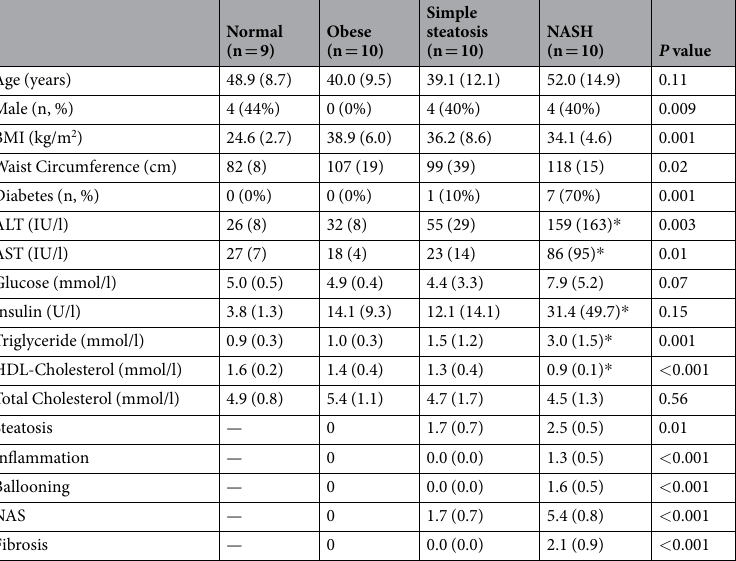
Table 1. Clinical and biochemical characteristics of control, simple steatosis and NASH patients. Footnote: Continuous data presented as mean (standard deviation). Comparison between groups performed using Chi-squared test, or ANOVA with comparison between Simple Steatosis and NASH groups with Bonferroni correction, apart from histological parameters, which are compared using Mann-Whitney U test. * p < 0.05 for post-hoc comparison between simple steatosis and NASH